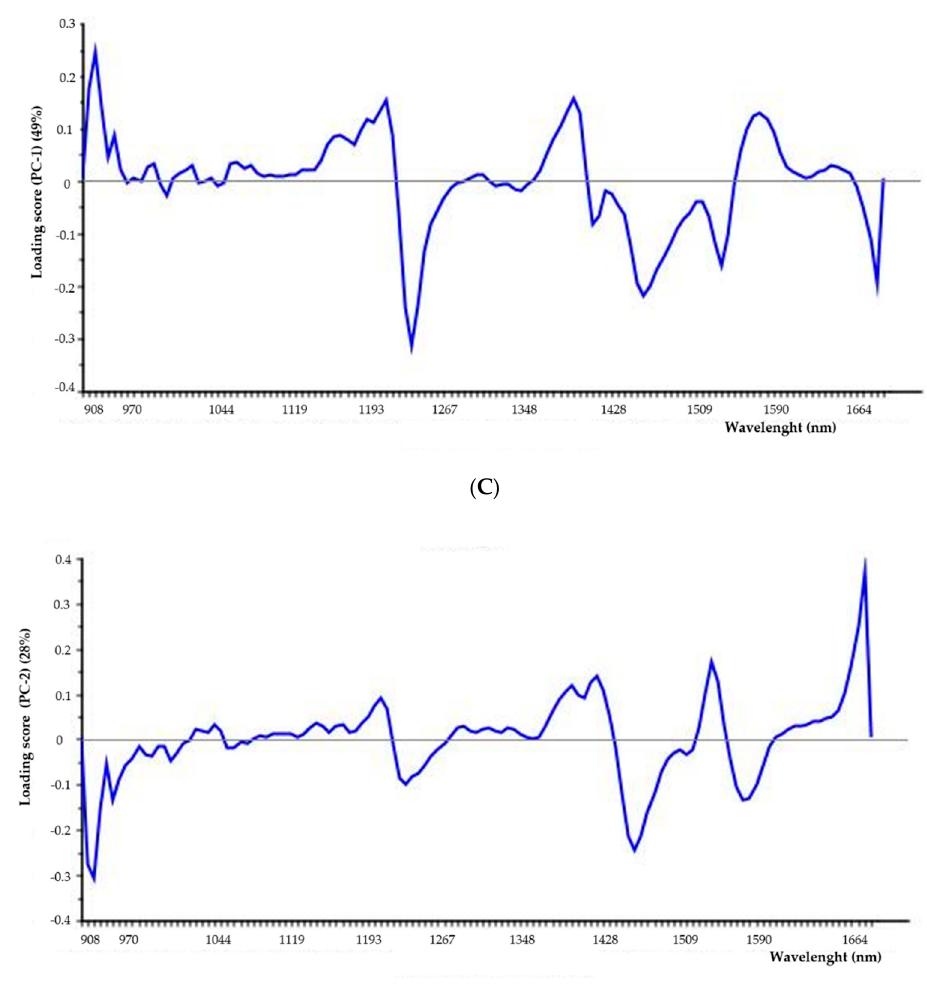
Figure 4. Results from near-infrared (NIR) analysis of chitosan (CH), trehalose powder, placebo microstructured carrier without CH (MLC); placebo microstructured carriers with chitosan (CH-MLC) and physical mixtures between CH and placebo freeze-dried CH-MLC. ( A ) Spectra; ( B ) principal components analysis (PCA) scores plot; ( C ) and ( D ) loadings plots of PC1 and PC2, respectively.